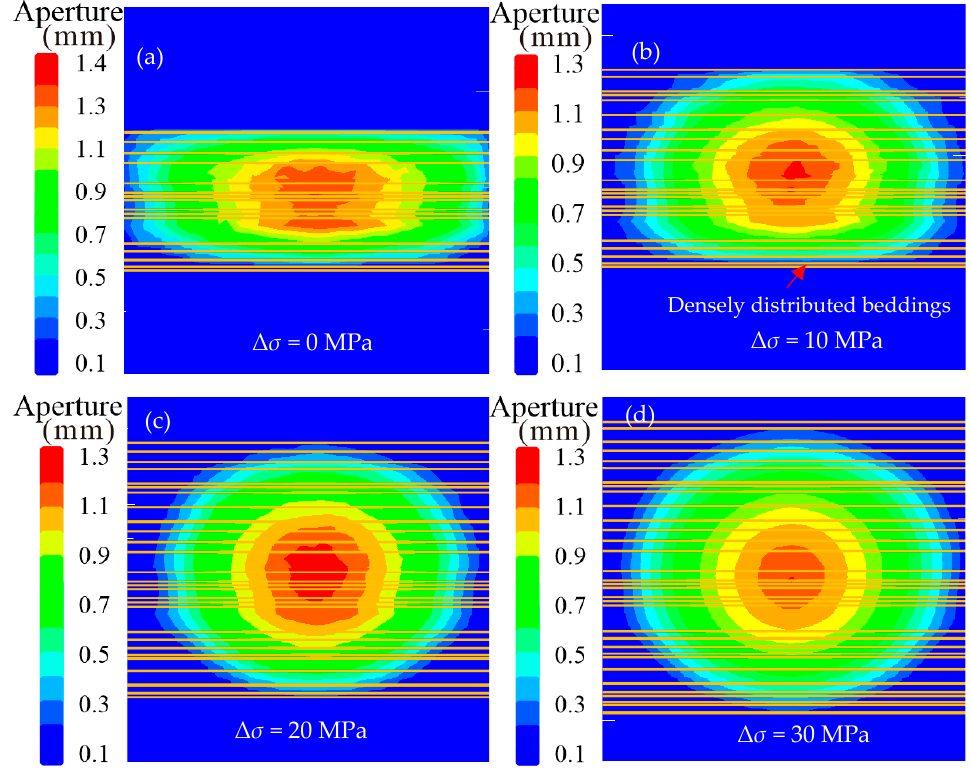
Figure 6. Fracture geometry and aperture distribution in different cases of stress configurations: